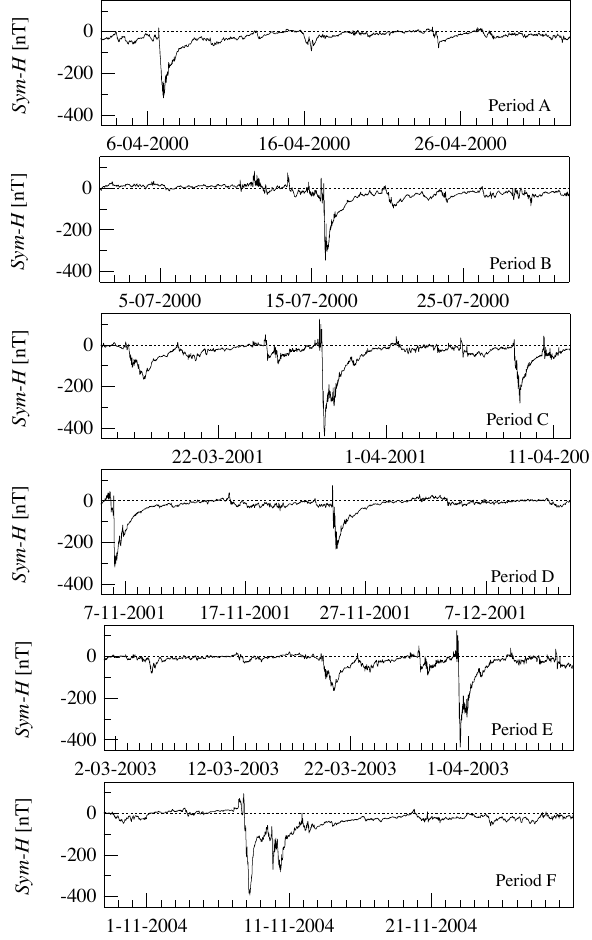
Fig. 1. 1-min Sym-H(t) time series of the six selected time periods. an energy-weighted measurement of the mean frequency in Fourier space.